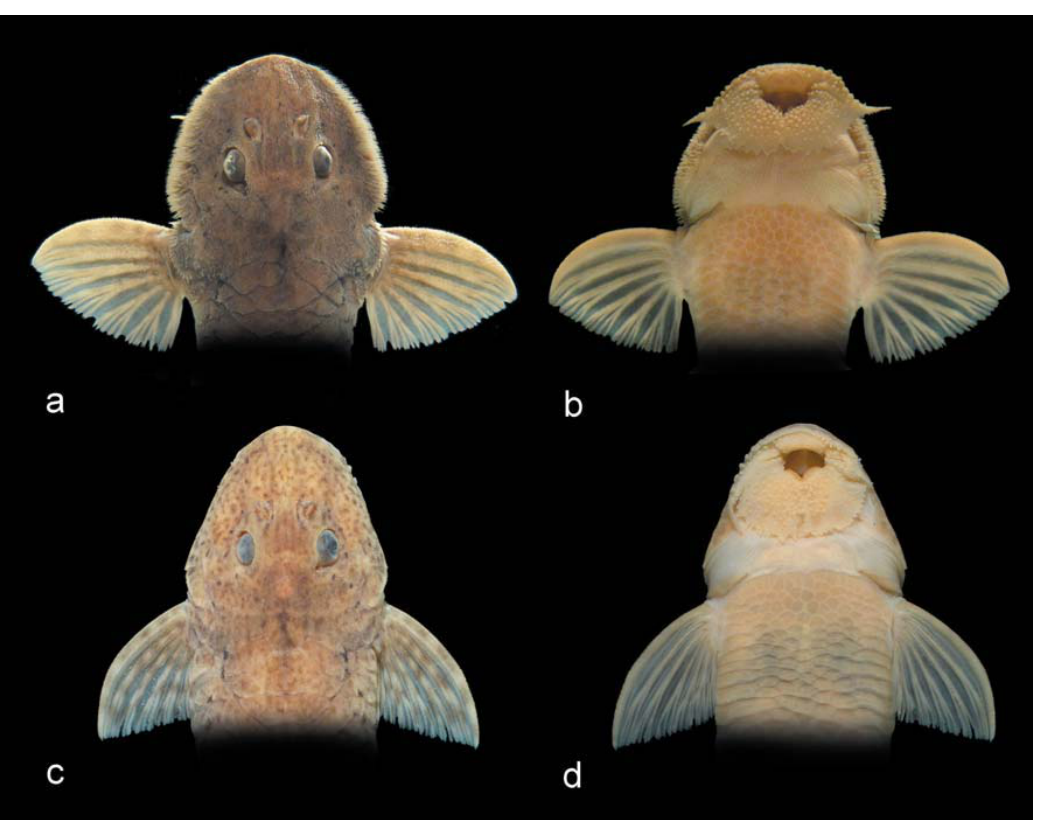
Fig. 3. Rineloricaria osvaldoi , dorsal and ventral views of the anterior region of the body ( a and b , male, MZUSP 89022 126.3 mm SL, c and d , female, MZUSP 89075, 125.7 mm